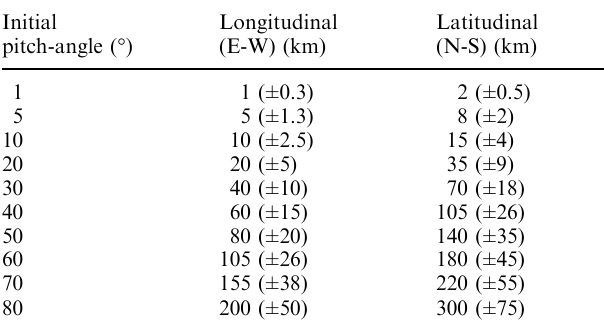
Table 2. Main dispersion region Initial pitch-angle ( (cid:176) )